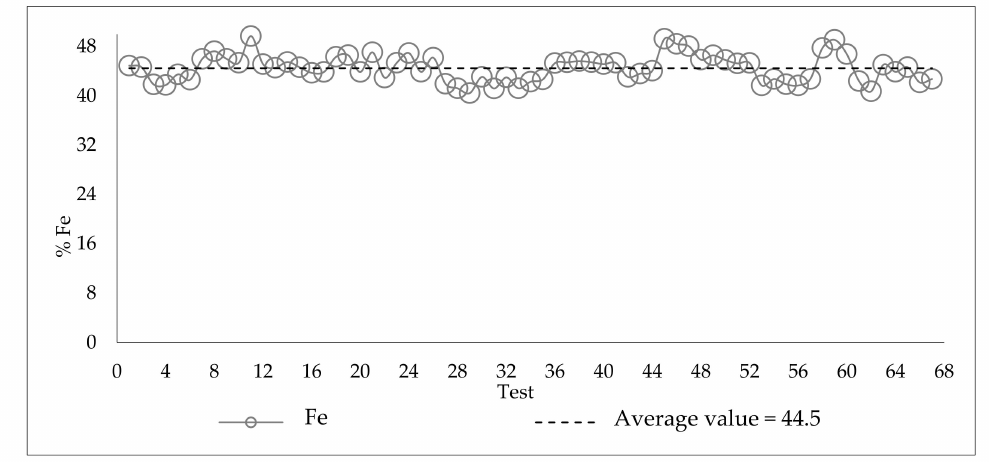
Figure 8. Variation of values concerning the Fe content in the flotation feed during the pilot